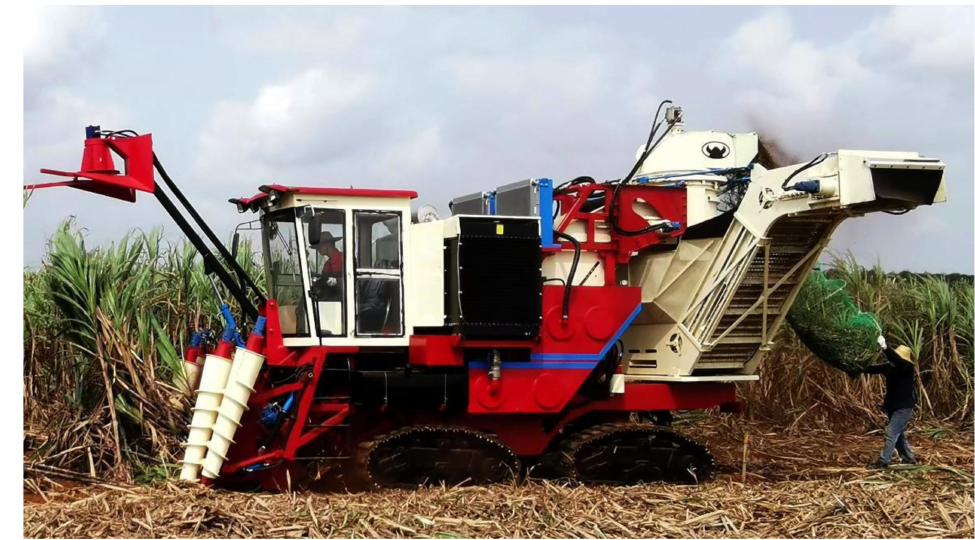
Figure 16. Field test of the trash removal system. During the gas-solid coupling simulation and field test, the speed extractor was 1100 r/min,